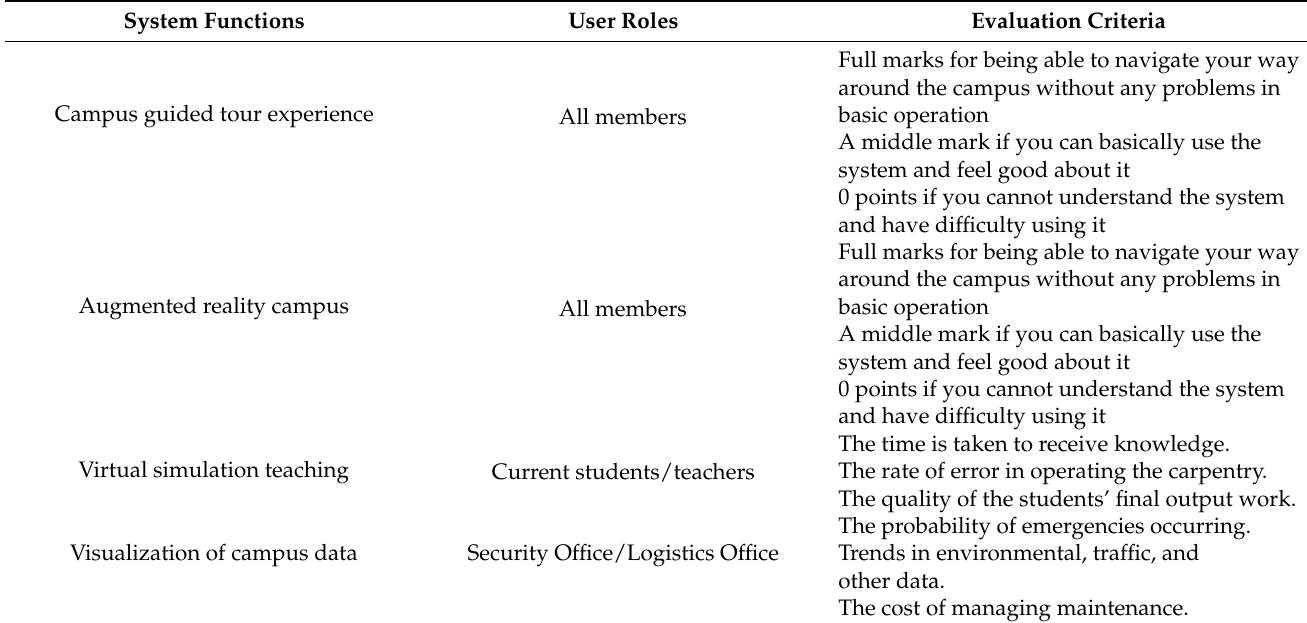
Table 3. Systematic evaluation